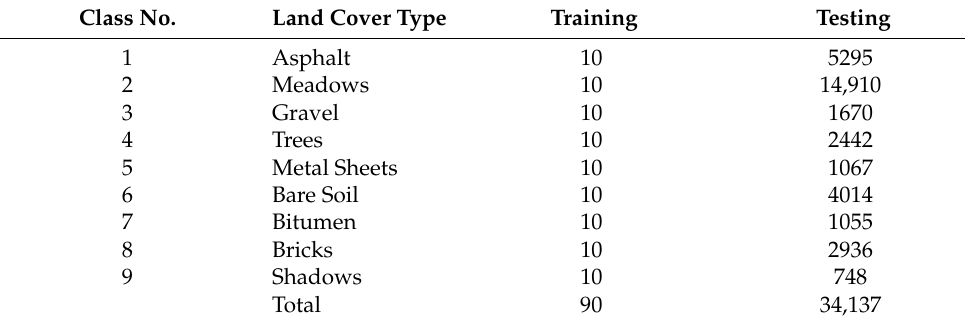
Table 2. The number of training, testing samples in the University of Pavia dataset. Class No.